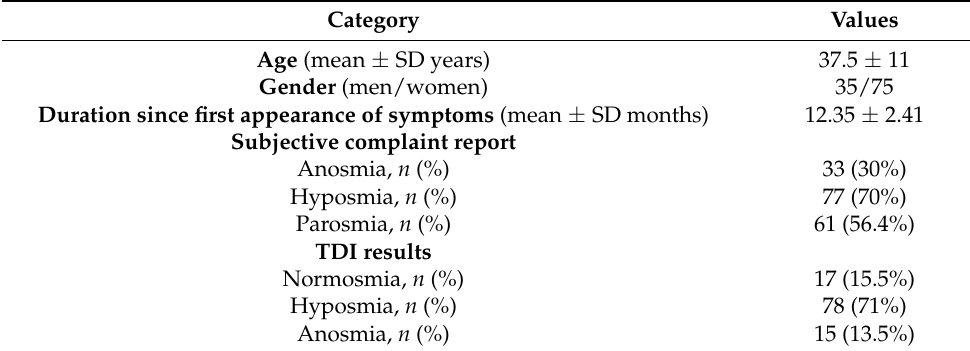
Table 1. Participants’